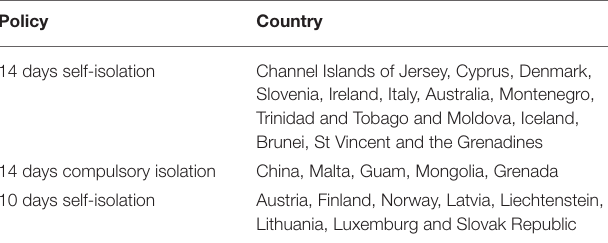
TABLE 2 | Summary of different types of isolation and quarantine policies. Policy